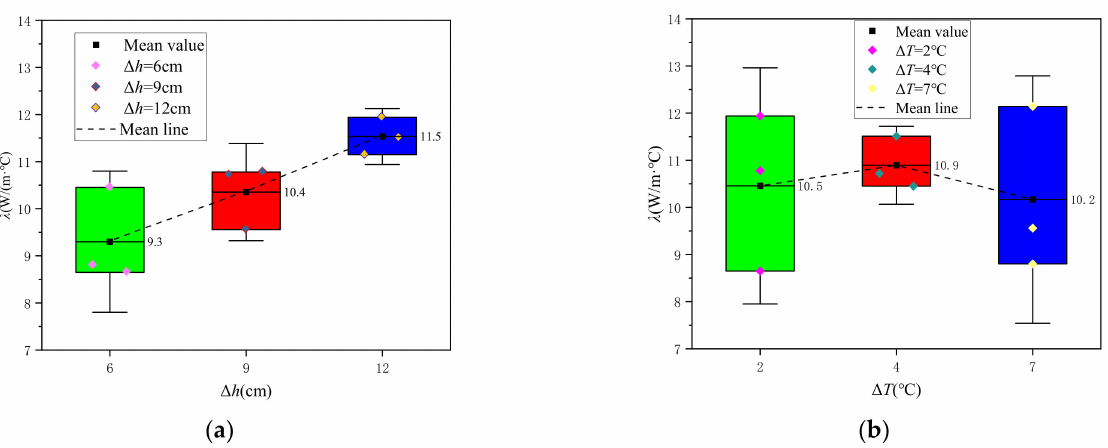
Figure 10. Calculated value of effective thermal conductivity in the case of u (cid:54) = 0. ( a ) Calculated values of effective thermal conductivity for different flow rates (The colors of green, red, blue respectively correspond to data sets under three different water head differences); ( b ) Calculated values of effective thermal conductivity for different excitation strengths (The colors of green, red, blue respectively correspond to the data sets under three different heat excitation